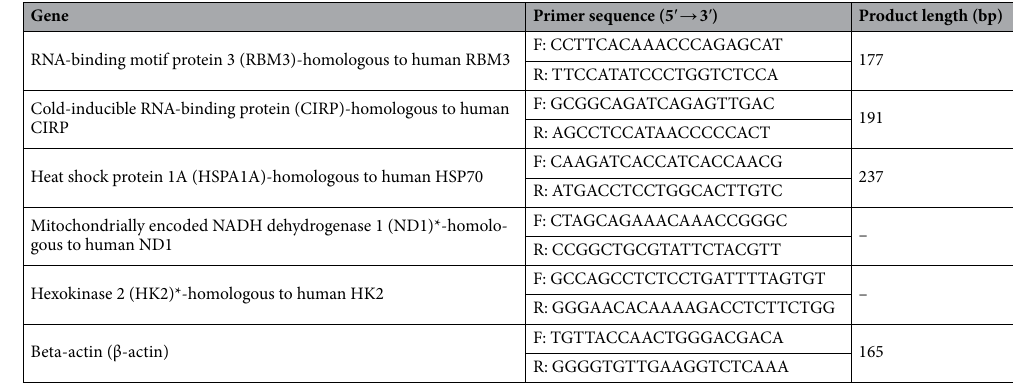
F: CCT TCA CAA ACC CAG AGC